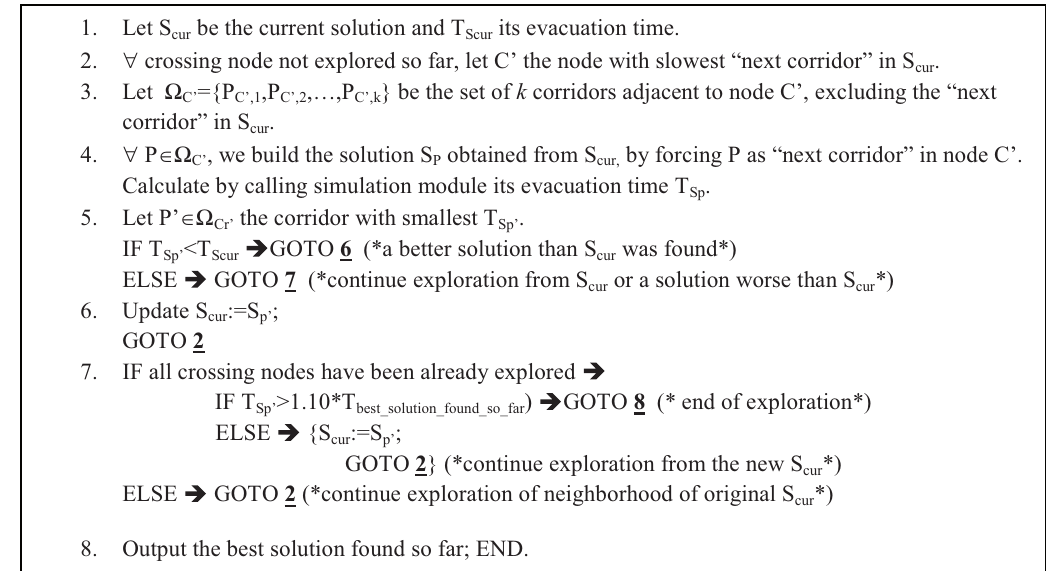
Fig. 3. Pseudocode for the optimization phase of the system.